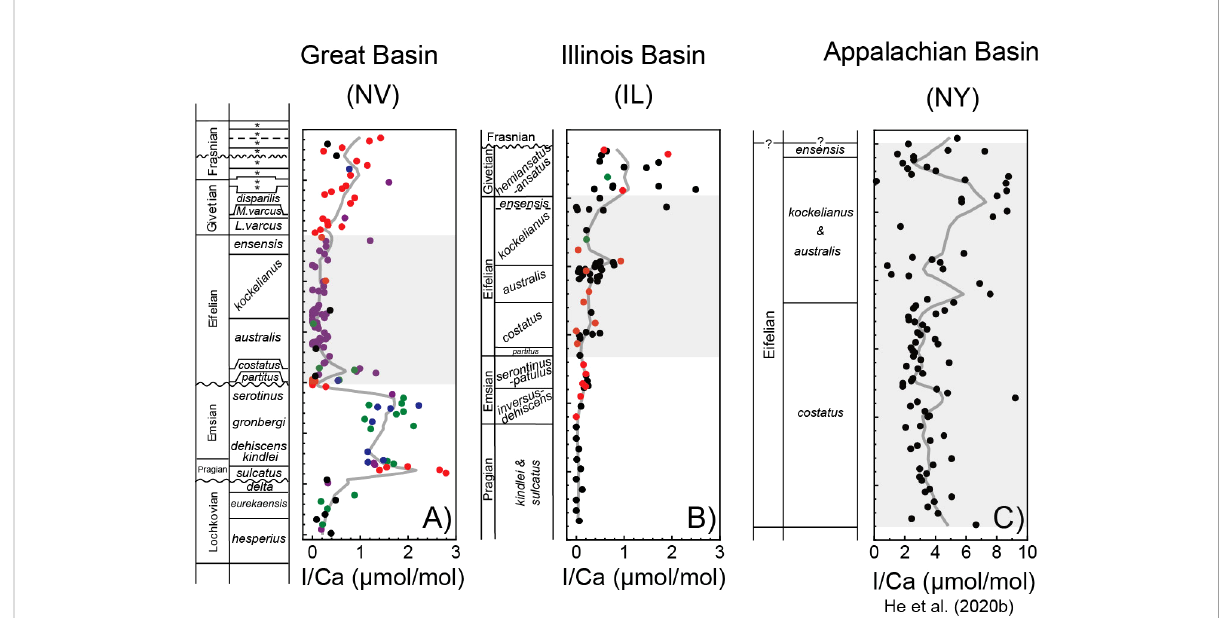
FIGURE 6 I/Ca comparisons among the three basins: (A) Great Basin, (B) Illinois Basin, (C) Appalachian Basin (He et al., 2020b). Gray shadings identify the Eifelian interval overlapping between all three basins for comparison. A closer comparison for the Eifelian stage is in Supplementary Figure S2. Color code for lithological groups: grainstone (red), packstone (blue), wackestone (green), lime mudstone (purple), unassigned (black). *Conodont zones not labelled are (in ascending order): norrisi, MN 1-2, MN 3, MN 6, hassi-jamieae, l. rhenana, u. rhenana, linguiformis